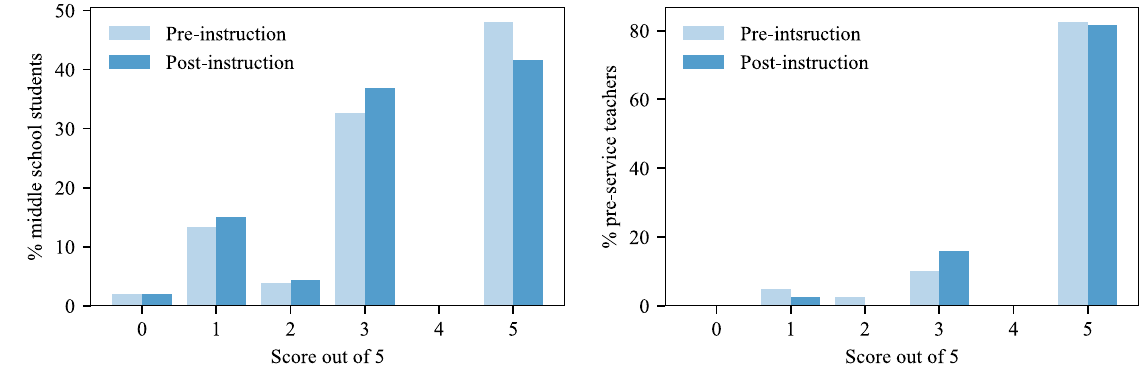
FIG. 1. Distribution of scores (number of items ranked correctly) for the ranking task in Q5a, for middle school students (left panel) and preservice teachers (right panel). The average score for the middle school students was 72.5% preinstruction and 69.6% postinstruction; the average score for the preservice teachers was 90.5% preinstruction and 91.6% postinstruction.